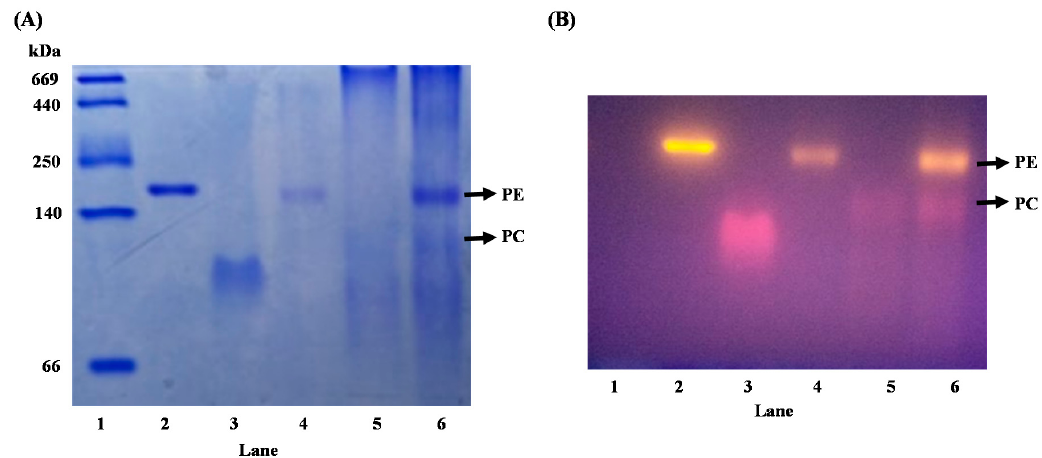
Figure 5. Native-PAGE chromatogram of phycobiliproteins from Porphyra under ( A ) visible light and ( B ) ultraviolet light. Lane 1: Protein marker; Lane 2: R-PE standard; Lane 3: C-PC standard; Lane 4: R-PE fraction from FPLC; Lane 5: R-PC fraction from FPLC; Lane 6: UF > 100 kDa.